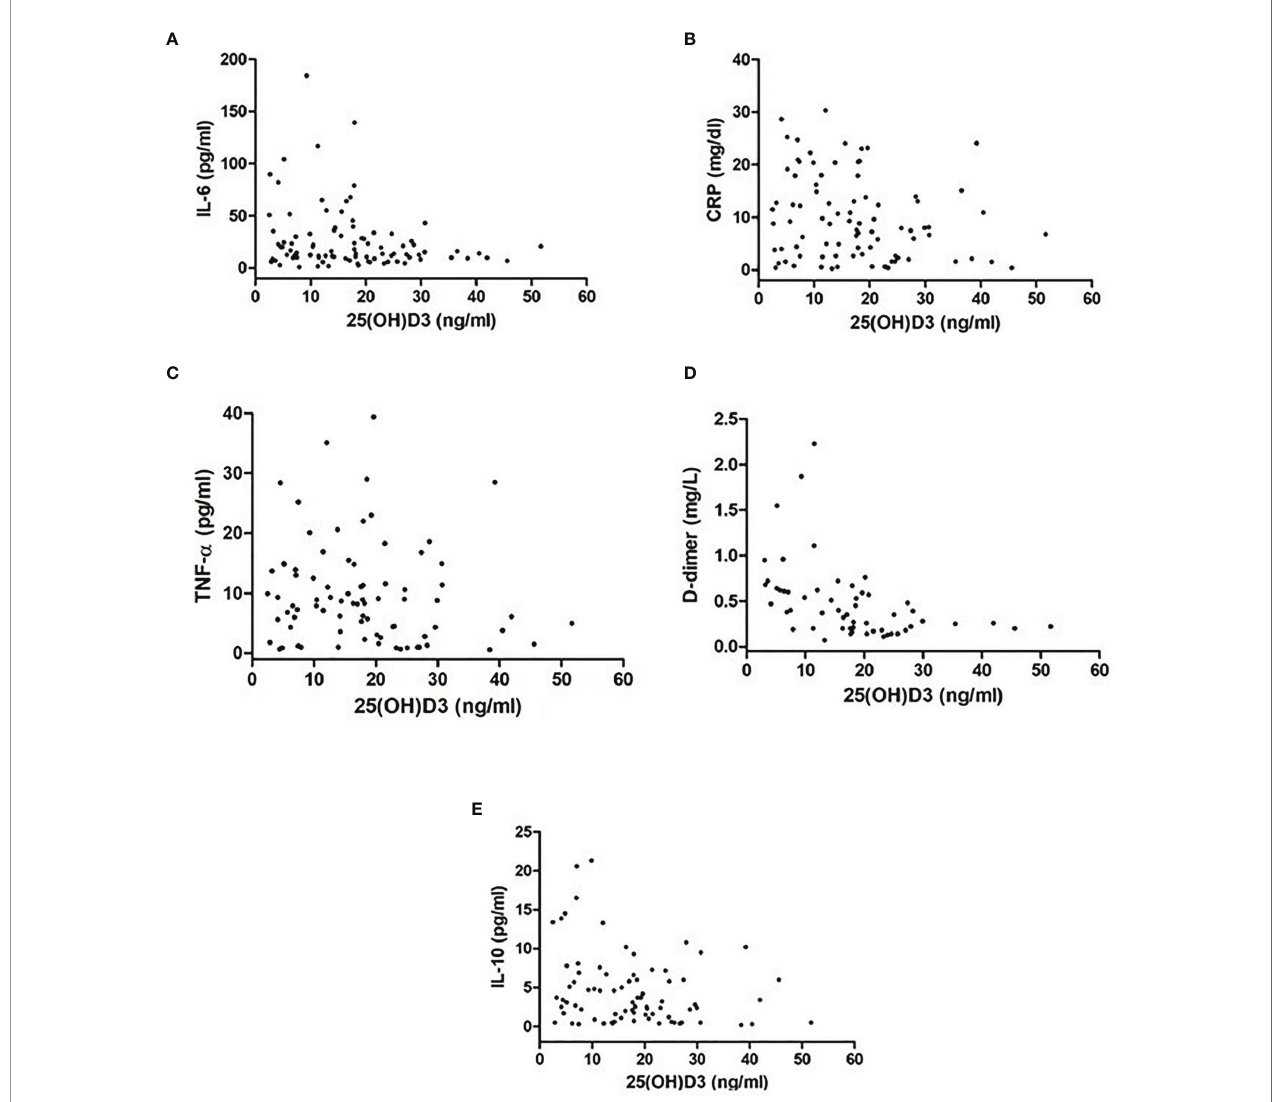
FIGURE 1 | Difference in in fl ammatory markers [ (A) IL-6, (B) CRP, (C) TNF- a , (D) D-dimer, (E) IL-10] between patients with 25OHD levels >20 ng/ml and those with 25OHD levels ≤ 20